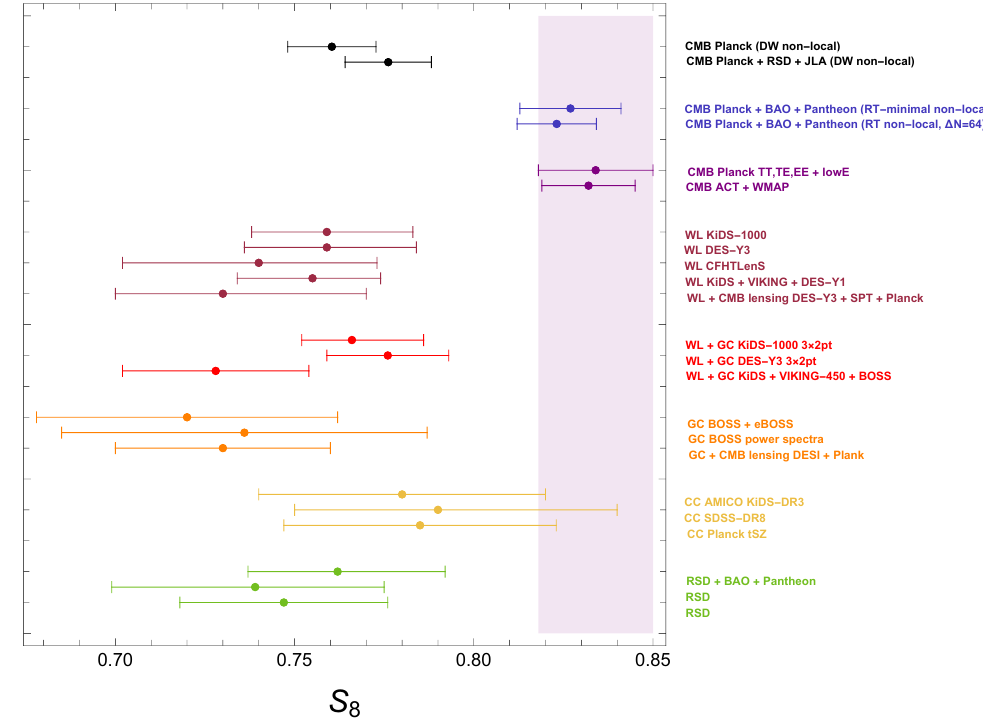
Figure 1. Estimates of S 8 provided by the two non-local cosmological analyses [56,98], and the Λ CDM fit of the CMB [5,66], the WL data [18,20,80,83,84,99], the combination of WL and galaxy clustering observations [100–102], cluster counting [19,87,88] and RSD surveys [92,94]. The colored band corresponds to the S 8 value derived by the analysis of the Planck–CMB data in the Λ CDM framework